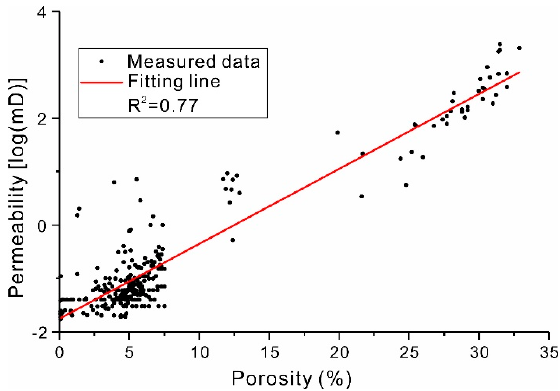
Figure 10. Correlation between the porosity and permeability in K 1 d reservoir.